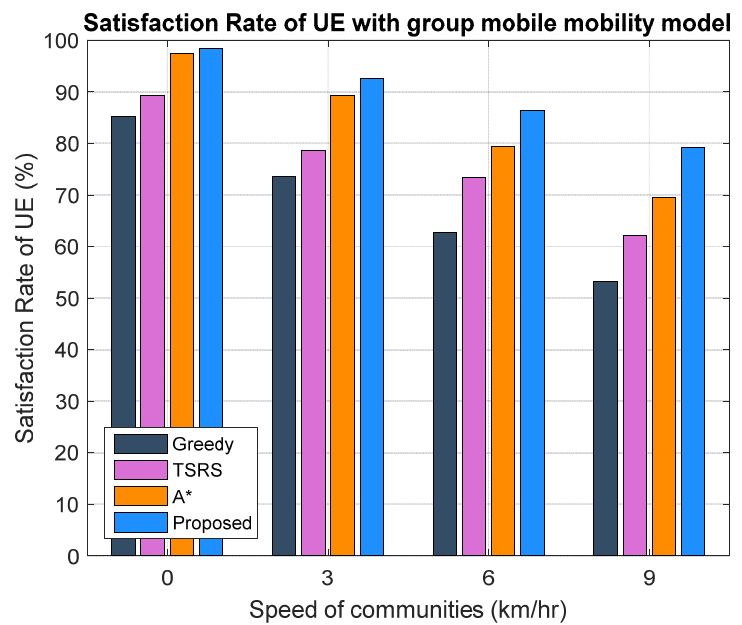
Figure 25. Satisfaction rate vs. group’s moving speed.